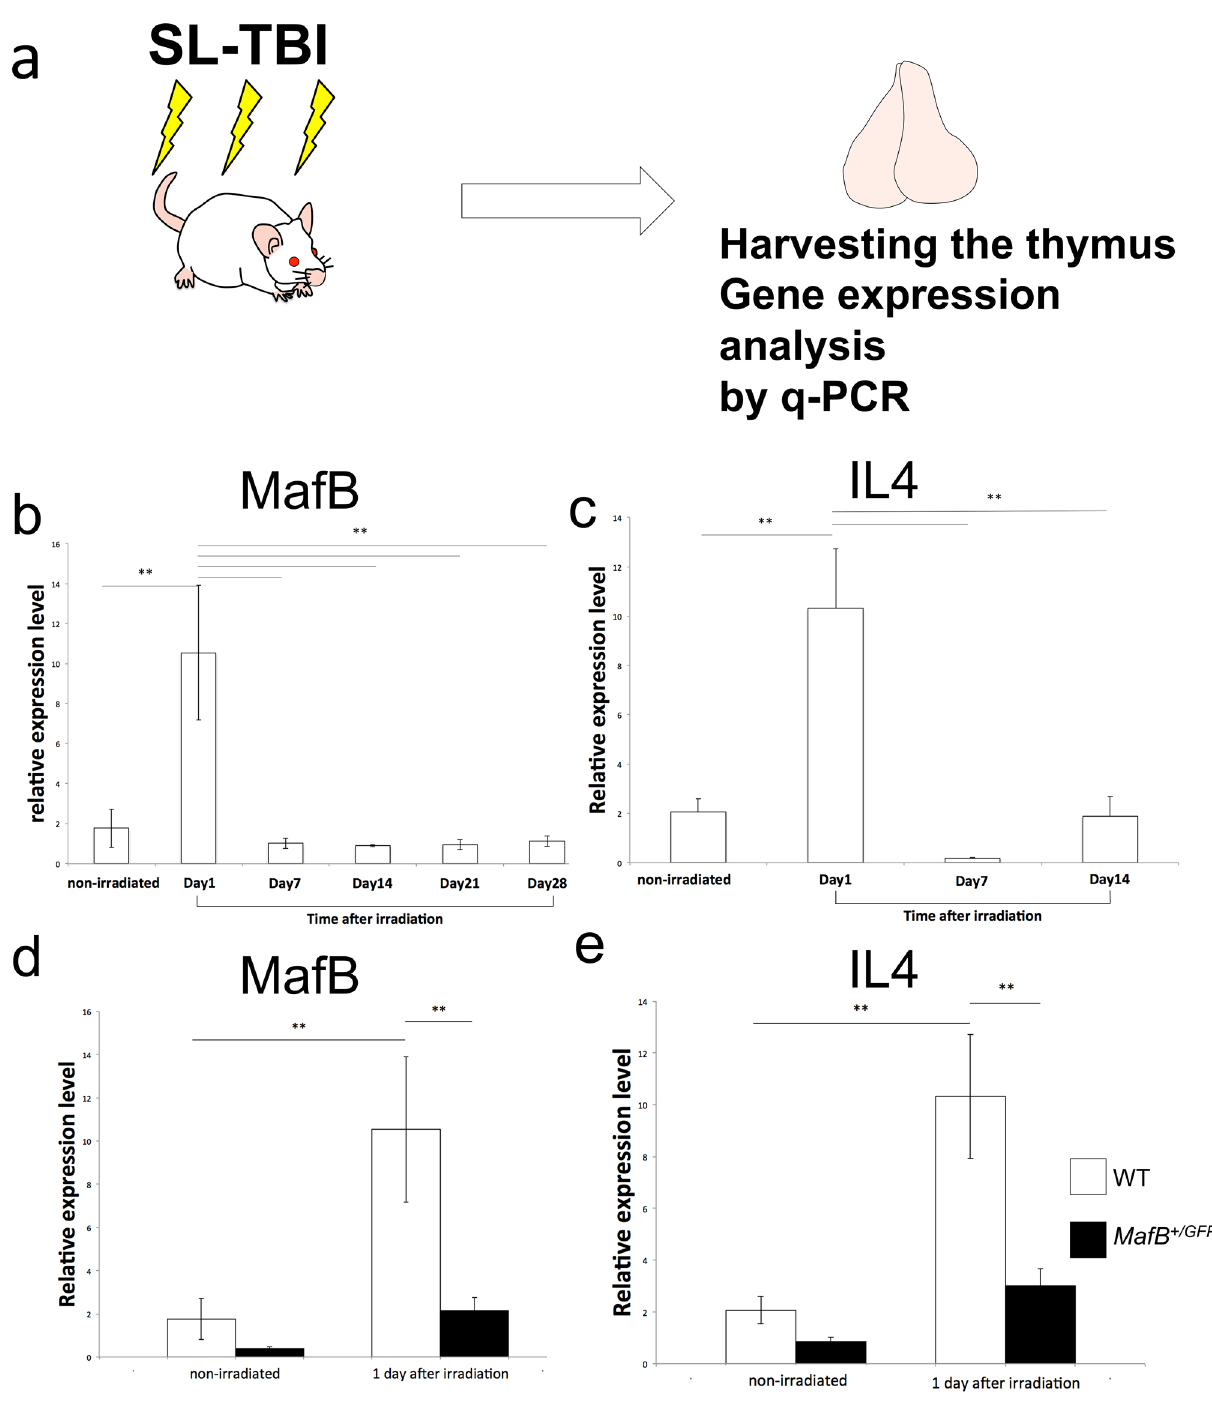
Figure 1. The induction of radiation induced genes, MafB and IL4, in the thymus. ( a ) The schematic illustration indicates the method to examine expression of radiation induced genes. Sublethal total body irradiation (SL-TBI) was performed. Thymic RNA was extracted and q-PCR was performed. ( b ) Prominent MafB gene induction after SL-TBI was detected at Day1 in WT. ( c ) The expression of IL4 after the SL-TBI. Prominent induction of IL4 was detected after 1 day SL-TBI. ( d ) The less prominent induction of MafB expression was reduced in the MafB + /GFP mutant mice. ( e ) The less prominent of IL4 induction after irradiation in the MafB + /GFP mutant mice. *P < 0.05, **P < 0.01 (Tukey Kramer